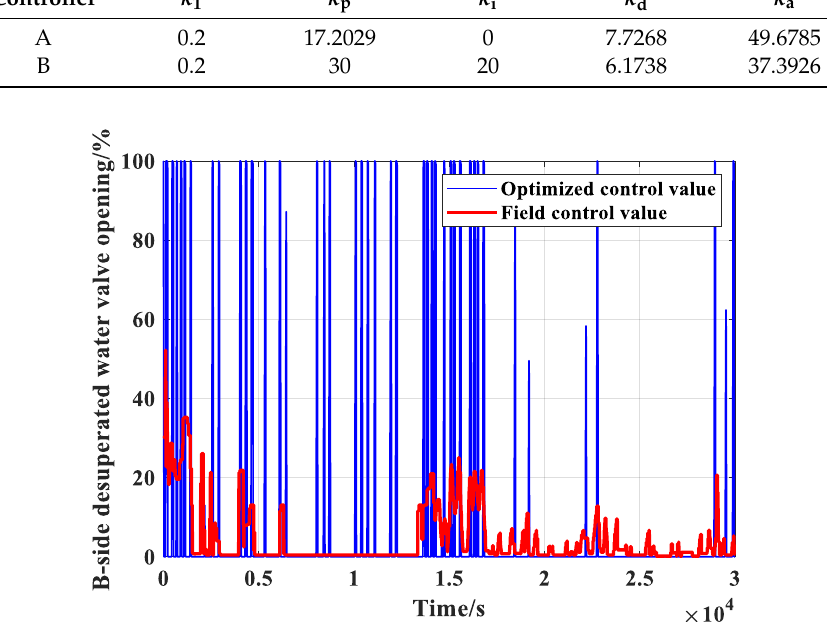
Figure 14. Output of controller B.